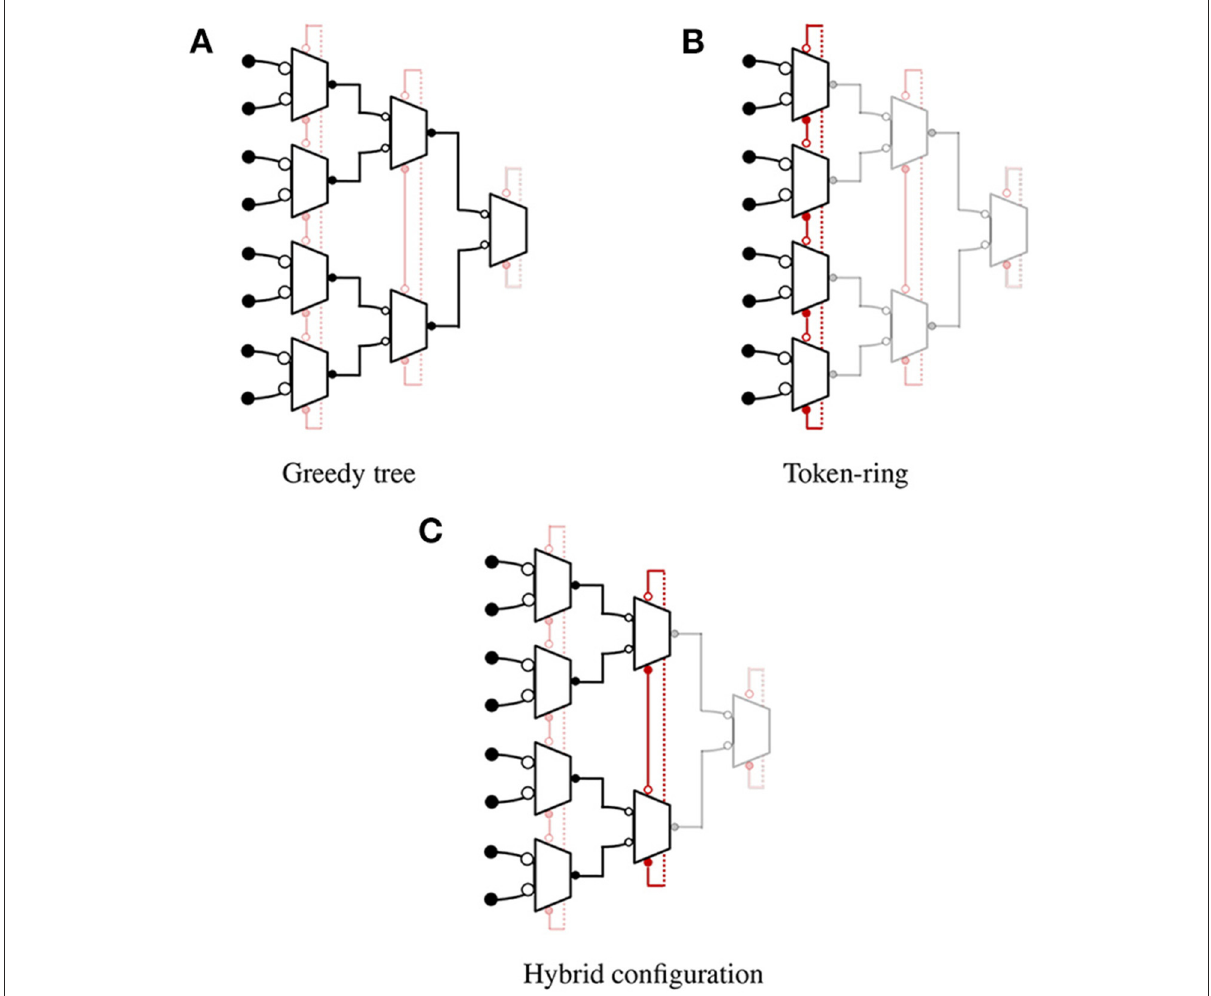
FIGURE3 Field-Programmable AER (FP-AER) configurations. The operation of each block is set by programming configuration bit. ⊸ denotes the passive end of the channel and denotes the active end of the channel. (A) Greedy tree. (B) Token-ring. (C) Hybrid −•